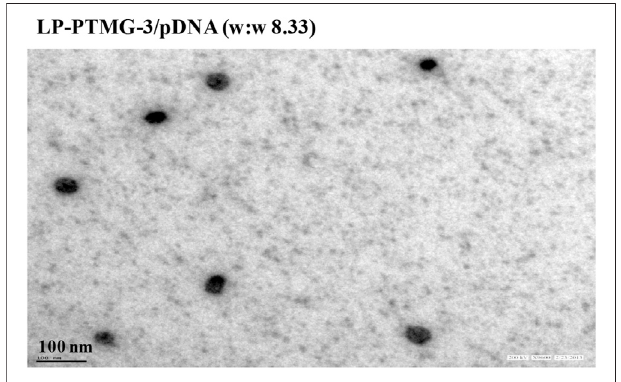
FIGURE 1 | TEM image of LP-PTMG-3/pDNA